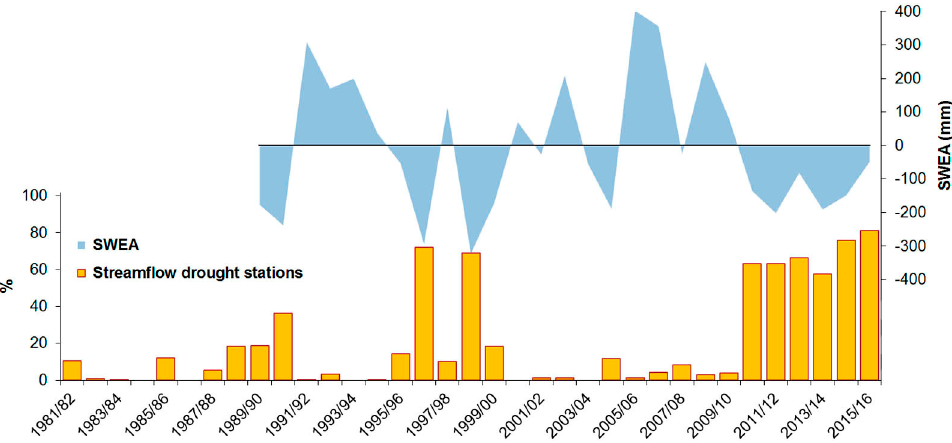
Figure 9. Temporal evolution of mean regional snow water equivalent anomalies (SWEA; 1989–2015) and mean annual (July to June) percentage of stations showing hydrological droughts (1981/1982 to 2015/2016).